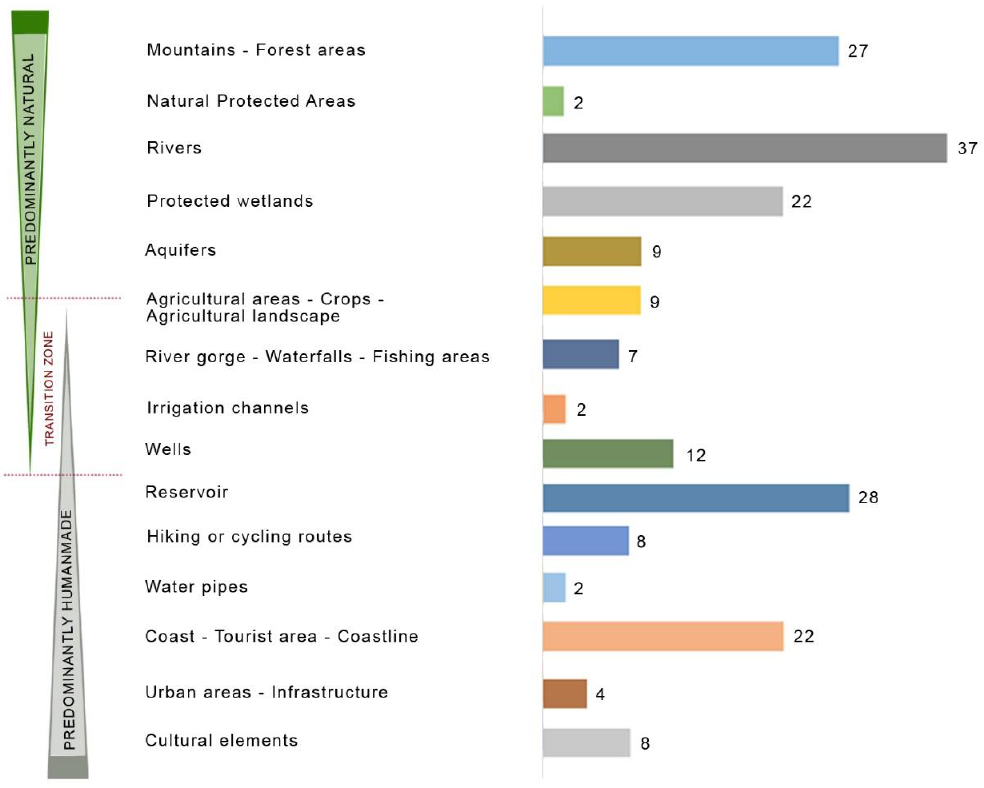
Figure 6. Gradient of elements mentioned as predominantly natural or humanmade and frequency of mentions as service provision hotspots SPH, service benefiting areas hotspots SBAH, or degraded service provision hotspots dSPH (adapted from Palomo et al. [60].